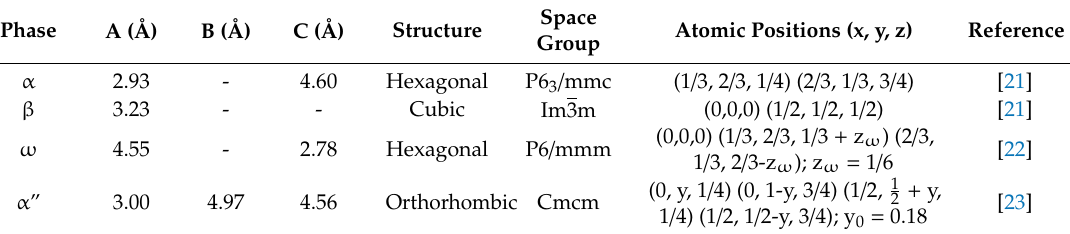
Table 1. Crystallographic data of phases considered for Rietveld